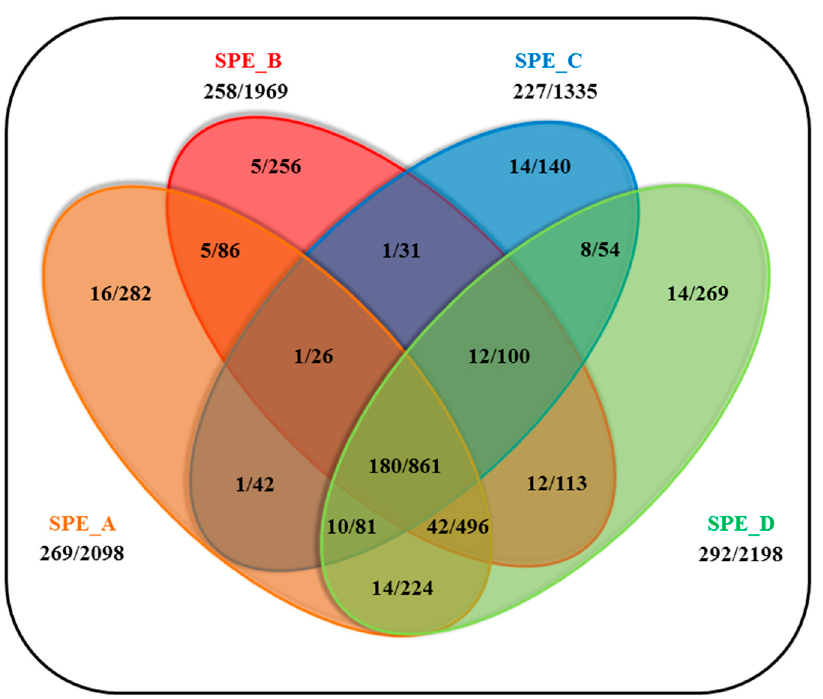
Figure 3. Venn diagram showing the number of individually labeled CSPs and the number of their labeled peptides in the various SPE experiments. Only those proteins (and their peptides) were taken into account that have been identified with at least one labeled position (i.e., positions that have been detected at least three times).